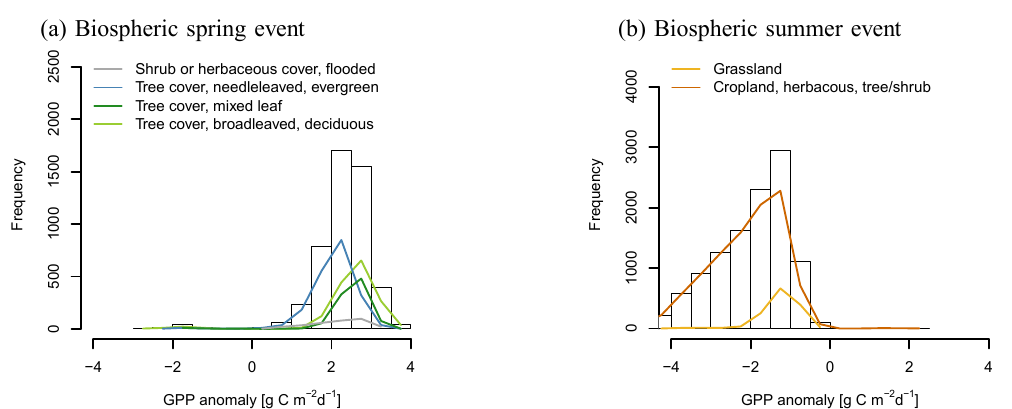
Figure C1. Histogram of GPP anomalies (reference period: 2001–2011) for different land cover classes constrained by (a) biospheric spring and (b) biospheric summer